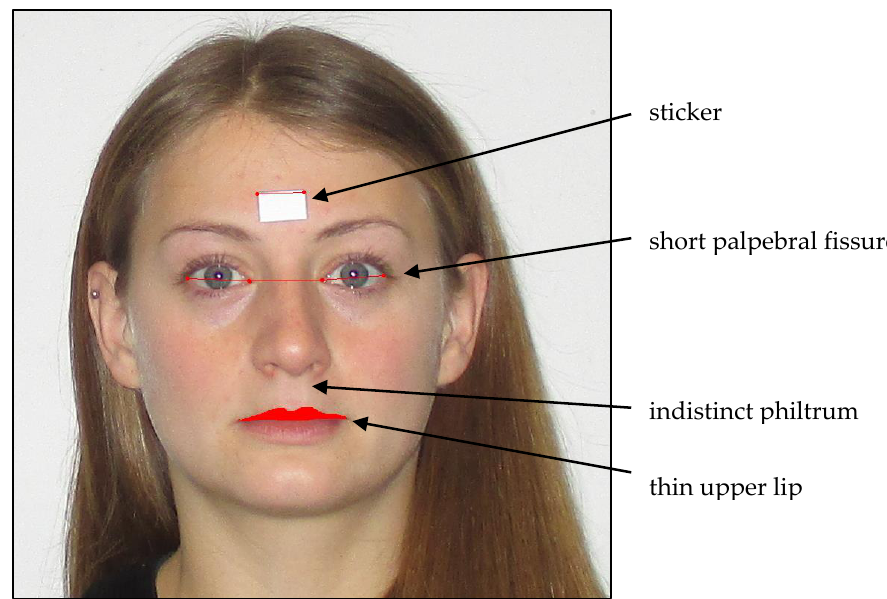
Figure 1. Typical facial abnormalities in fetal alcohol syndrome (FAS) children and FAS software measures (modeled in a non-affected adult person).